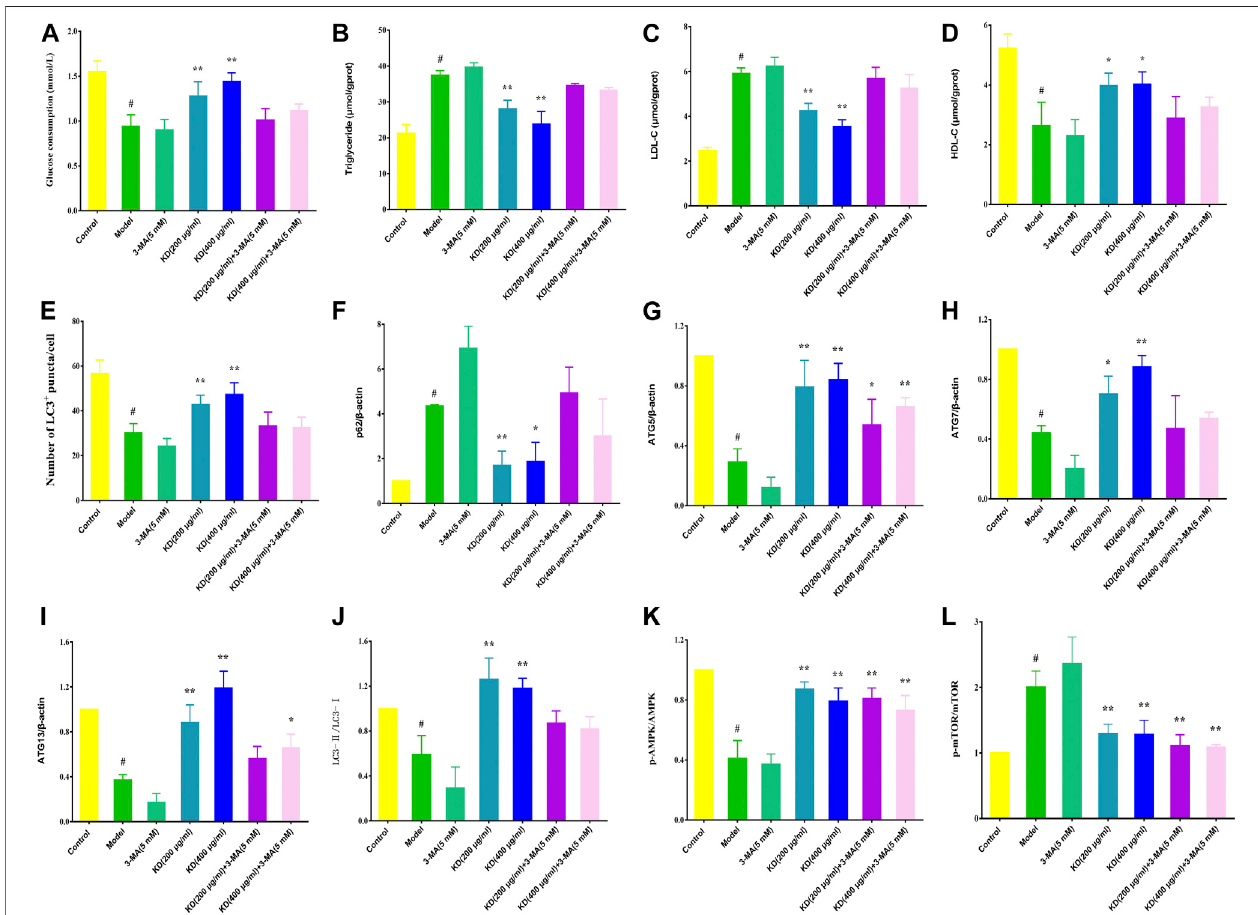
FIGURE6| 3-MAweakensthetherapeuticeffectofKDoninsulinresistanceinLO2cells.LO2cellswereincubated inDMEMwith0.5%fattyacid-freeBSAoroleic acid(0.25 mM)for24 h,andthenwerepretreatedwith3-MA(5 mM)for1 handweretreatedwithorwithoutKD(200and400 μ g/ml)for24 h.Theglucoseconsumption ofhepatocytes (A) ;Theintercellulartriglyceride (B) ,LDL-C (C) andHDL-C (D) contentsofoleicacid-inducedhepatocytes;The autophagy fl ux ofhepatocyte (Eand O) ; theoilredOstainingofoleicacid-inducedhepatocytes (M,N) ;Westernblotanalysisforp62 (F) ,Atg5 (G) ,Atg7 (H) ,Atg13 (I) ,LC3- Ⅱ / Ⅰ (J) ,AMPK,p-AMPK(Thr172) (K) ,mTORandp-mTOR(Ser2448) (L)(P,Q) .Datawerepresentedasmean ± SD( n (cid:2) 3ineachgroup). # P < 0.01comparedwiththecontrolgroup,* P < 0.05,** P < 0.01 compared with the model